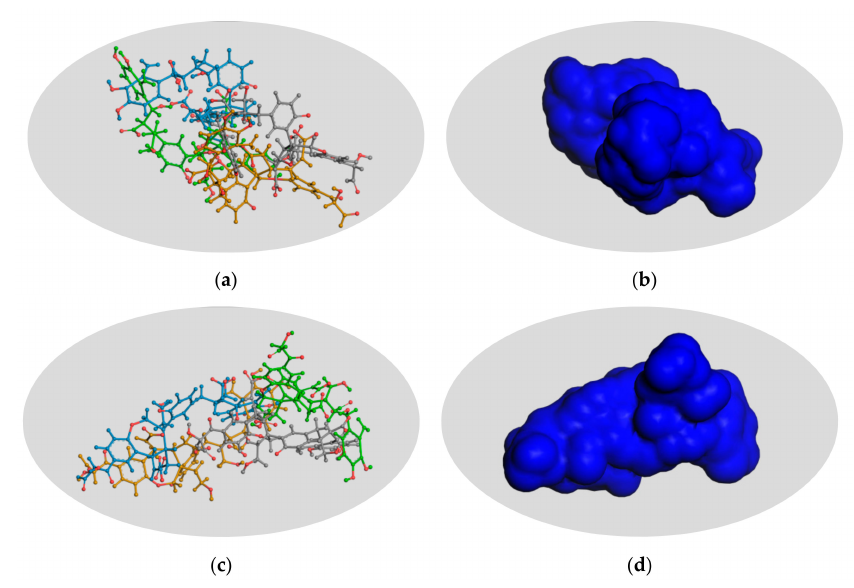
Figure 7. The morphology of TNB in ( a ) Ca 2 + -TNB and ( c ) Mg 2 + -TNB before calculation (solvent accessible surface areas) and of TNB in ( b ) Ca 2 + -TNB and ( d ) Mg 2 + -TNB after calculation.